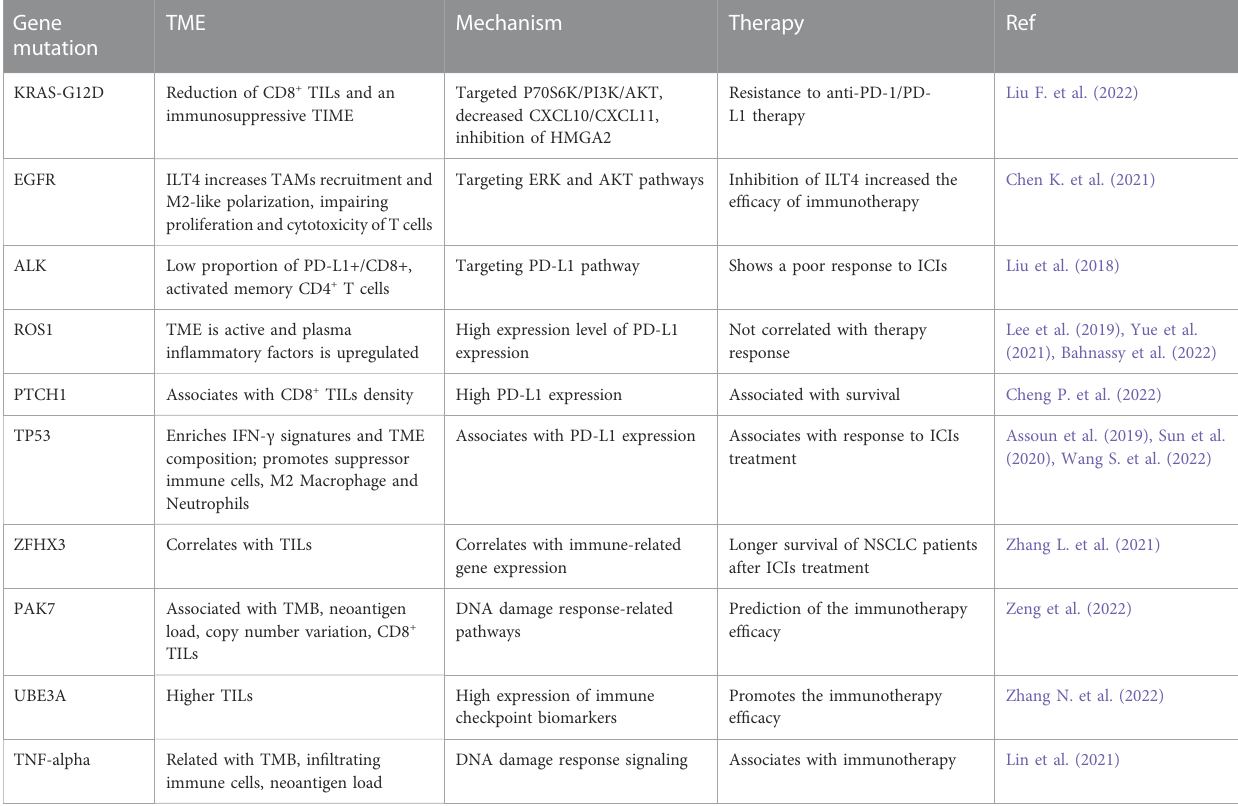
TABLE 1 The association of gene mutations and TME, immunotherapy in lung cancer. Gene